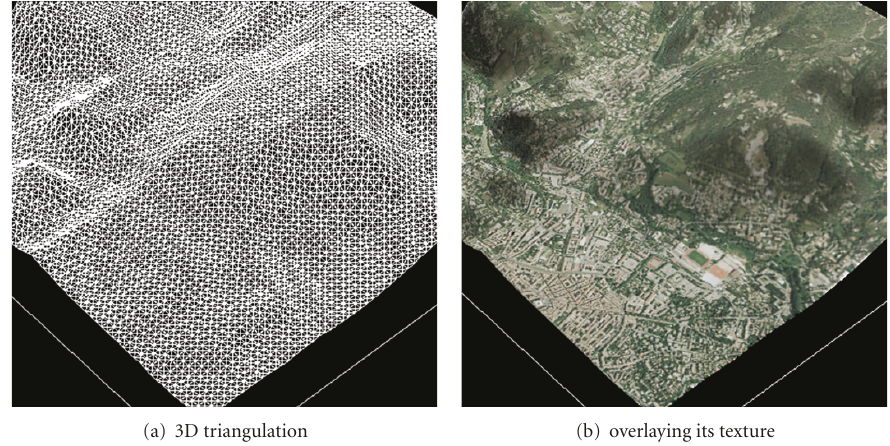
Figure 22: 3D views with the tessellation after smoothing with Method II: d m = 2, d h = 1 ( l h = 0, l m = 2, l l =